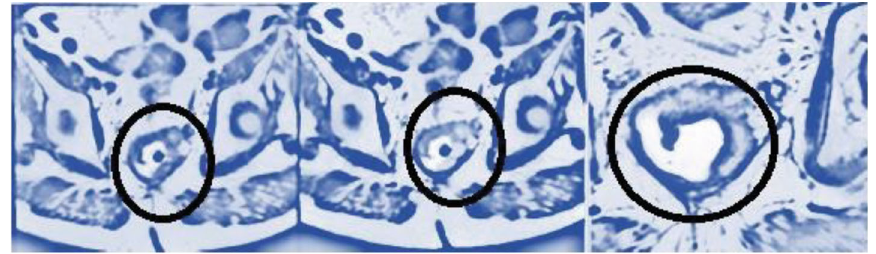
Figure 1: Example illustrating the 2D segmentation and the bounding box with the corresponding native image on an MRI baseline native image on the left, 2D segmentation in the middle, and bounding box on the